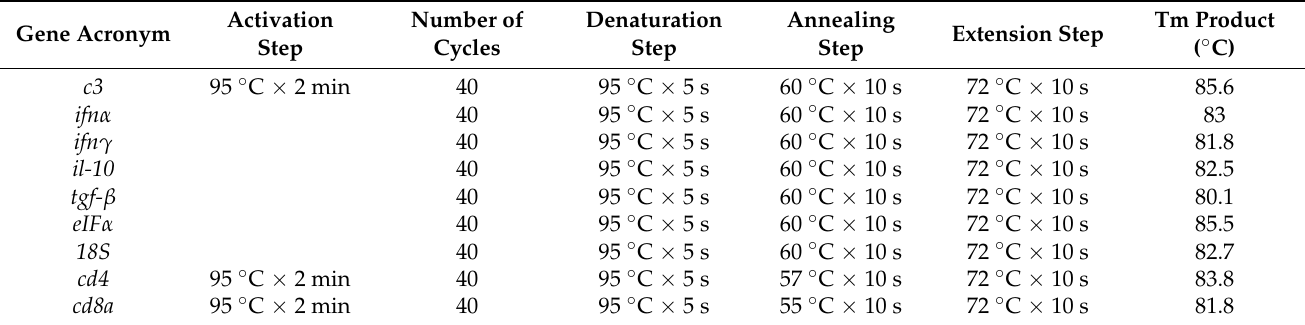
Table 1. qRT-PCR condition details for the primers